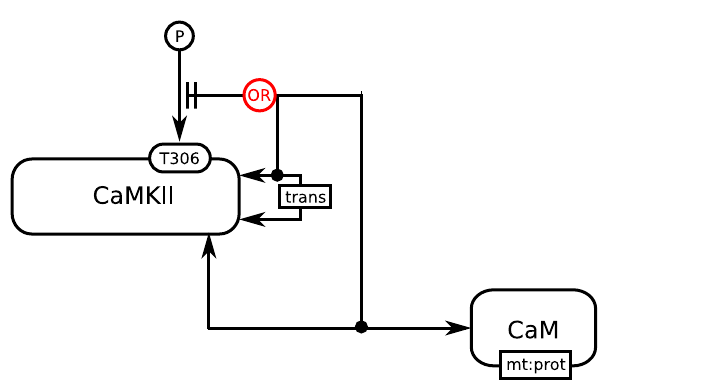
Figure 2.7: Example of the or logical operator, showing that either the dimerisation of CaMKII or its binding to Calmodulin preclude the phosphorylation of threonin 306.